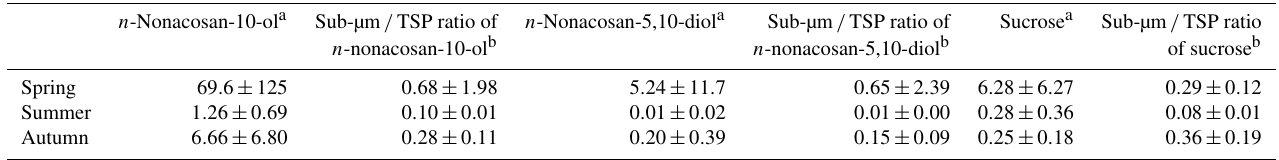
Table 2. The average concentrations of n -nonacosan-10-ol, n -nonacosan-5,10-diol, and sucrose in the submicrometer particles and the fractions of their mass to the TSP mass at the TMK site in 2015.